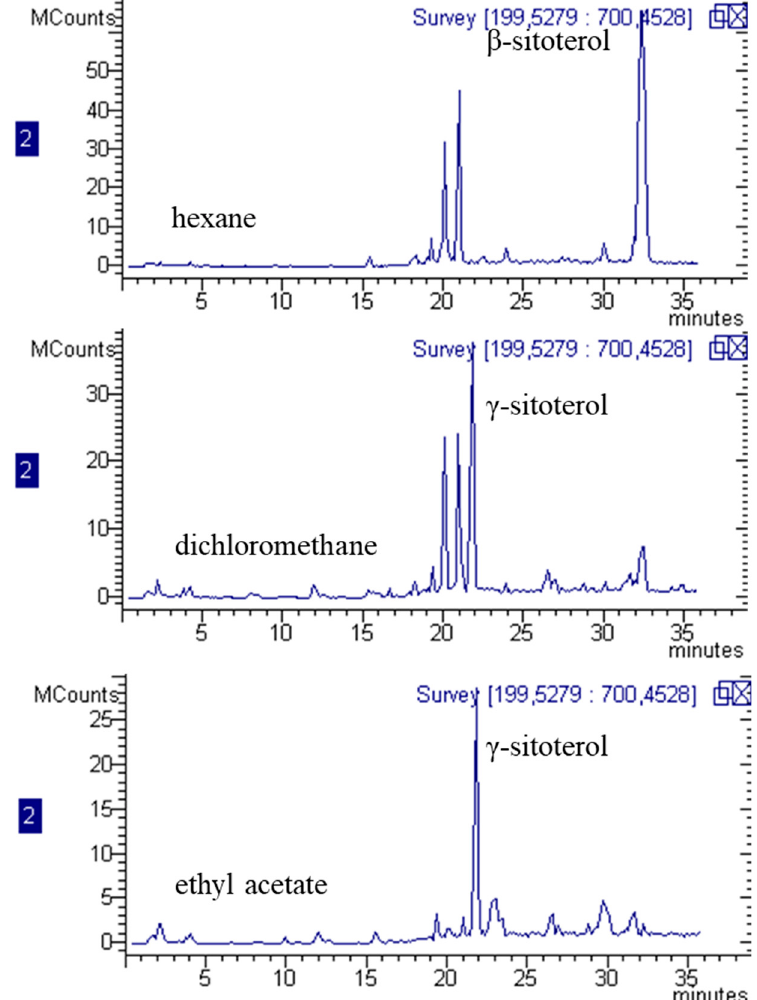
Figure 5. HPLC-MS chromatograms (base peak ion) of the three fractions obtained from the methanol